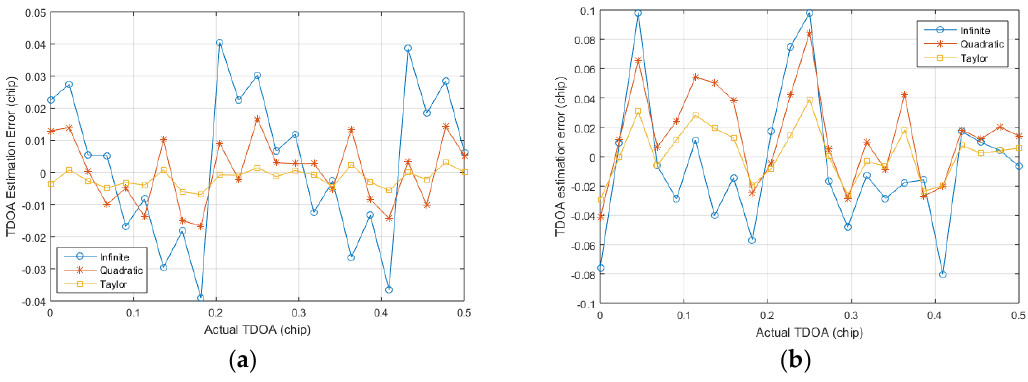
Figure 13. The time difference of arrival (TDOA) estimation errors under different setting code phase differences: ( a ) is SNR = 0 dB and ( b ) is SNR = −15 dB.